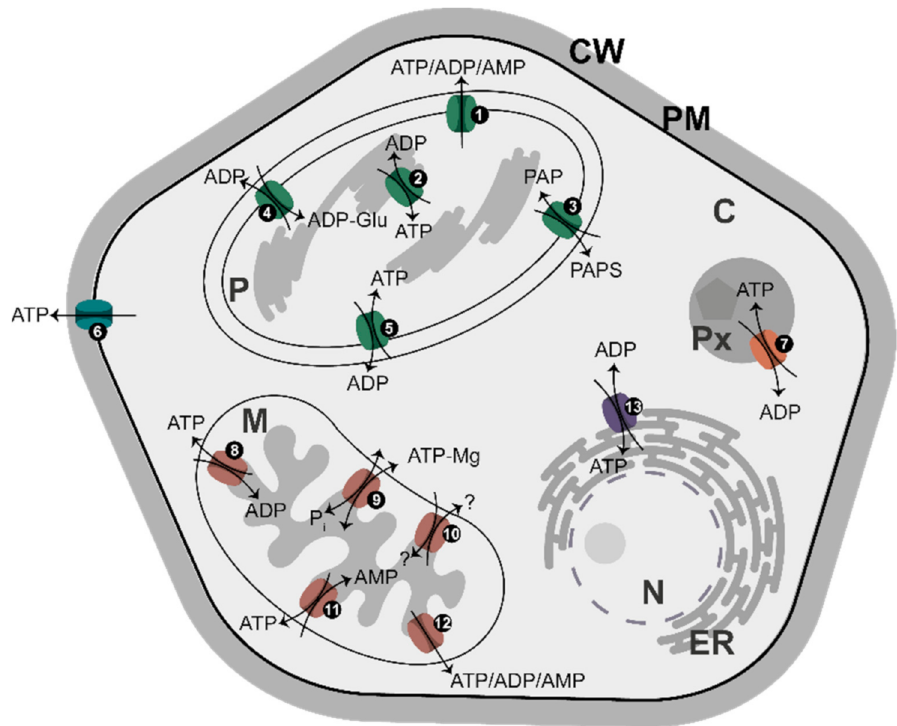
Figure 4. Distribution of major adenylate carriers in membranes in plants. The names of the trans- porters and major transported molecules are as they are given by da Fonseca-Pereira et al. [99]. The light-grey area corresponds to compartments where AK equilibrium is established. Num- bers correspond to: (1) AtBT1 , Arabidopsis thaliana ATP/ADP/AMP carrier; (2) ATP/ADP carrier; (3) TAAC/PAPST1; (4) ZmBT1, maize ( Zea mays ) plastid ADP-Glucose/ADP carrier; (5) NTT1-2, ATP/ADP carriers; (6) PM-ANT1; (7) PNC1-2, ATP/ADP carrier; (8) AAC1-3, ATP/ADP carriers; (9) APC1-3, MgATP/P i carriers; (10) ZmBT1, maize mitochondrial transporter, the substrate and transport mode of which are unclear; (11) ADNT1, AMP/ATP carrier; (12) AtBT1,